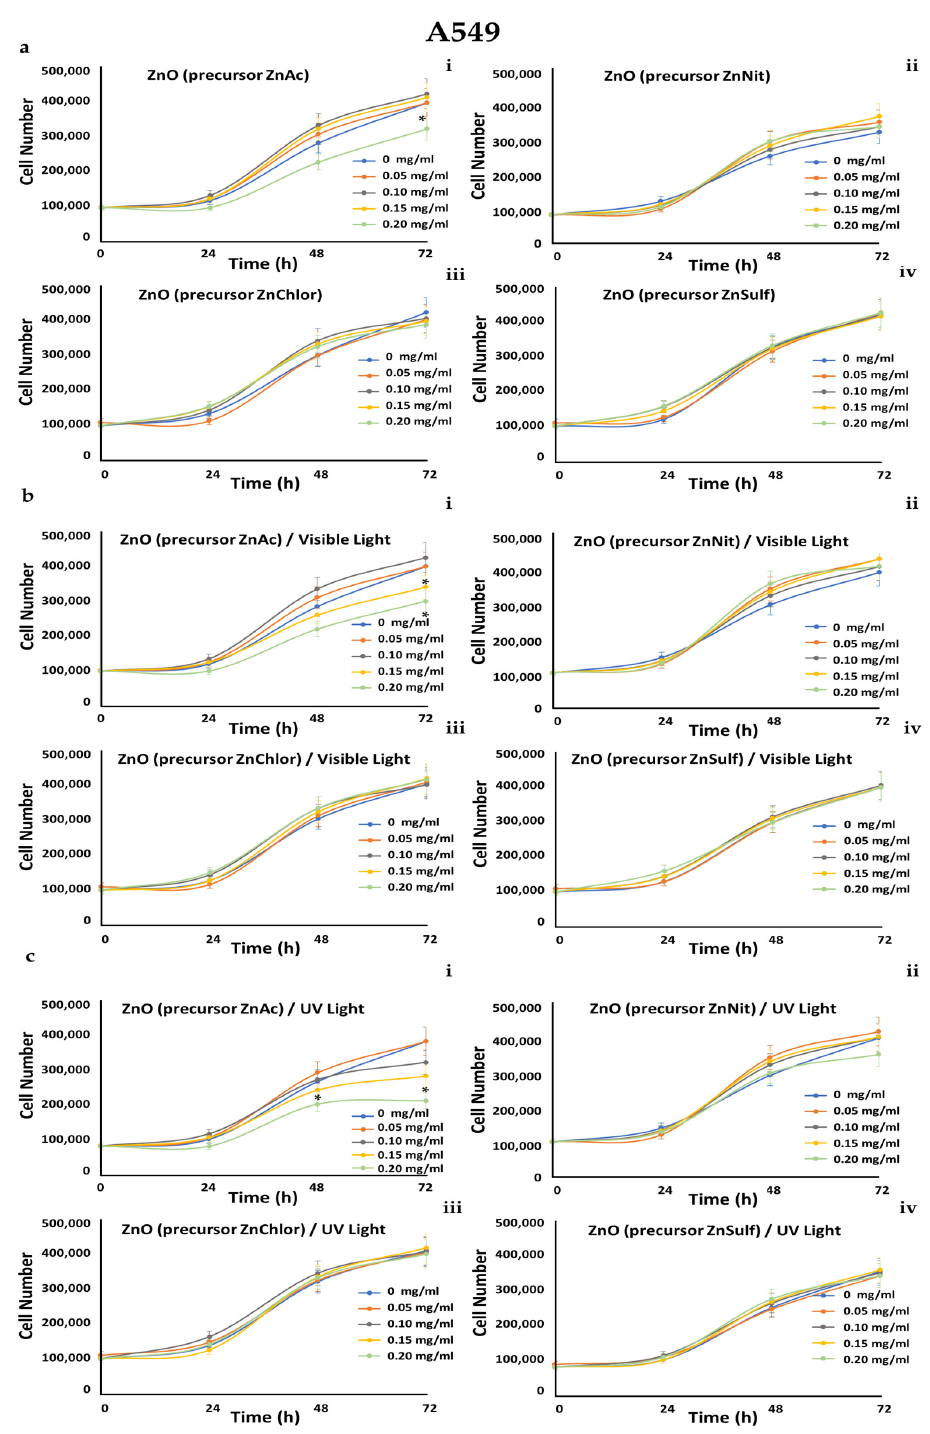
Figure 21. Growth rates of A549 cell line in the presence of ( a ) zinc acetate dehydrate (ZnAc), zinc nitrate hexahydrate (ZnNit), zinc chloride (ZnChlor), zinc sulphate heptahydrate (ZnSulf). ( b ) Photo-activated with visible light ZnAc, ZnNit, ZnChlor, and ZnSulf. ( c ) Photo-activated with UV light ZnAc, ZnNit, ZnChlor, and ZnSulf. ZnNit slightly decreased the cell population after photo-activation with UV, but this effect is not statistically significant. ZnAc has an important effect, reducing the cell number by 100,000 cells, at the concentration of 0.2 mg/mL. Photo-activation with visible light led to a further decrease of 0.15 and 0.2 mg/mL and even earlier (at 48 h) the UV-photoactivation allowed a significant decrease at the same concentrations. p < 0.05 was considered statistically